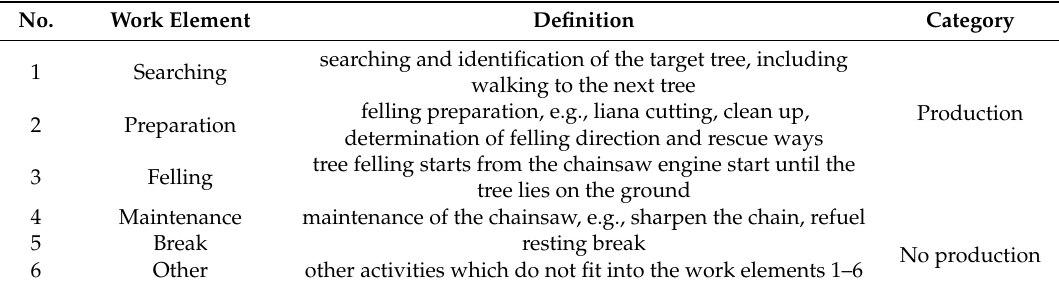
Table 2. Work elements for a time study during the FCT release ([35],